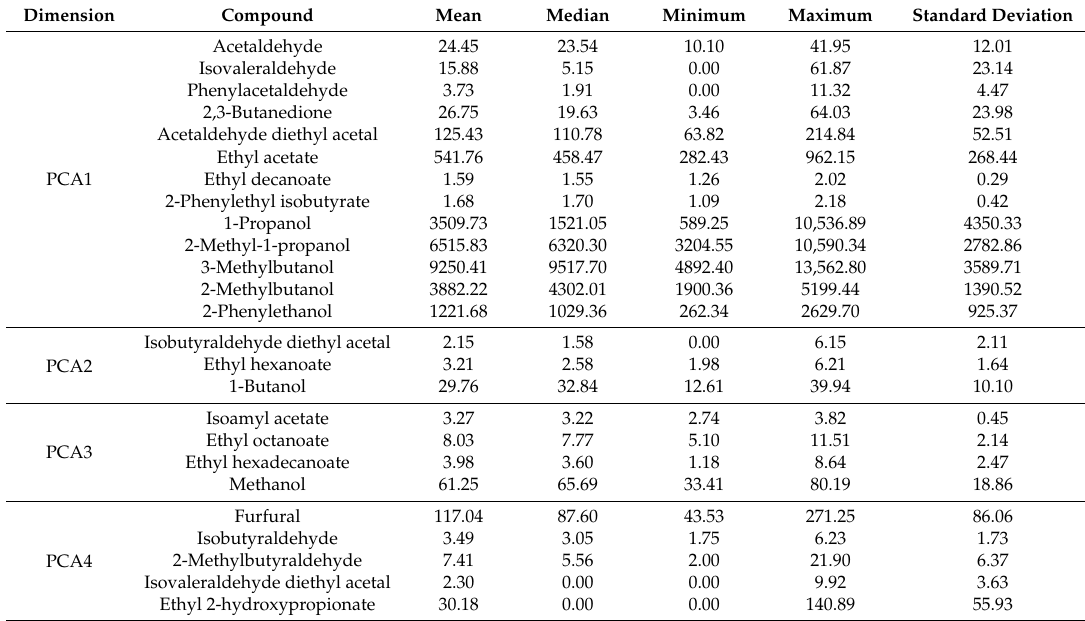
Table 10. Descriptive statistics for determined volatile compounds grouped into principal component analysis (PCA)